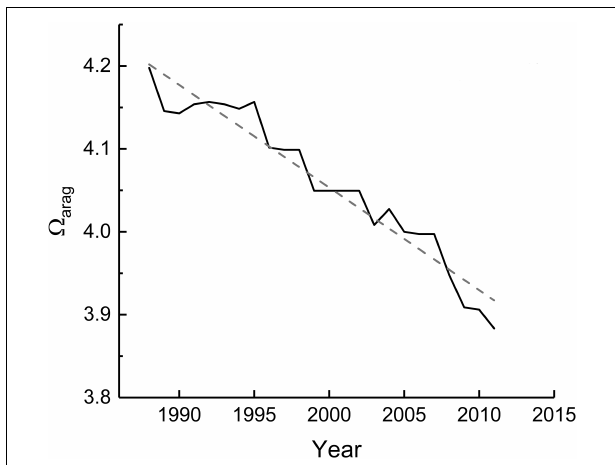
FIGURE 5 | Aragonite saturation state ( (cid:127) arag ) in the vicinity of Serrana Atoll, during 1988–2011 (solid line). The dashed line indicates a significant tendency ( r 2 = 0.94, p < 0.001) described by the equation y = 28.815 – 0.012 x